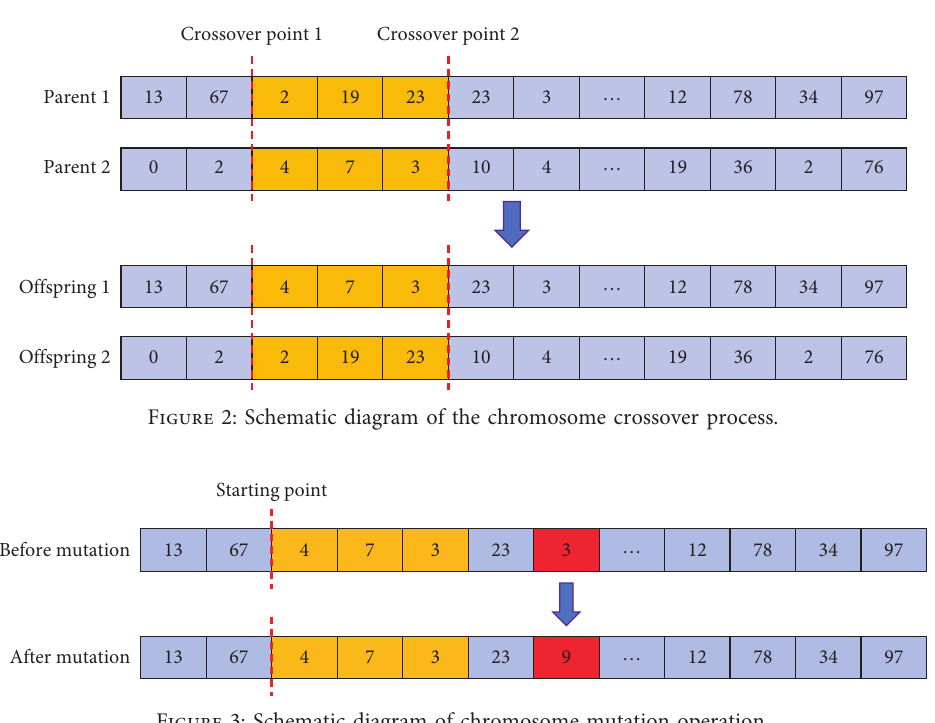
Figure 3: Schematic diagram of chromosome mutation operation.